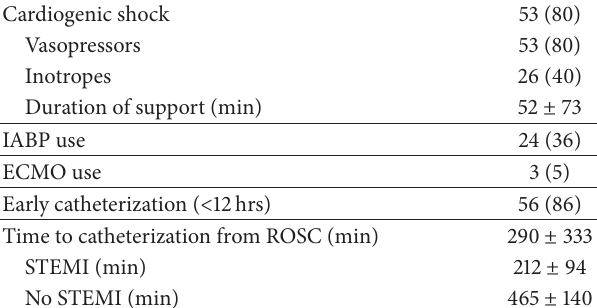
Table 3: In-hospital outcomes for total population ( 𝑛 = 176 ). Clinical characteristics